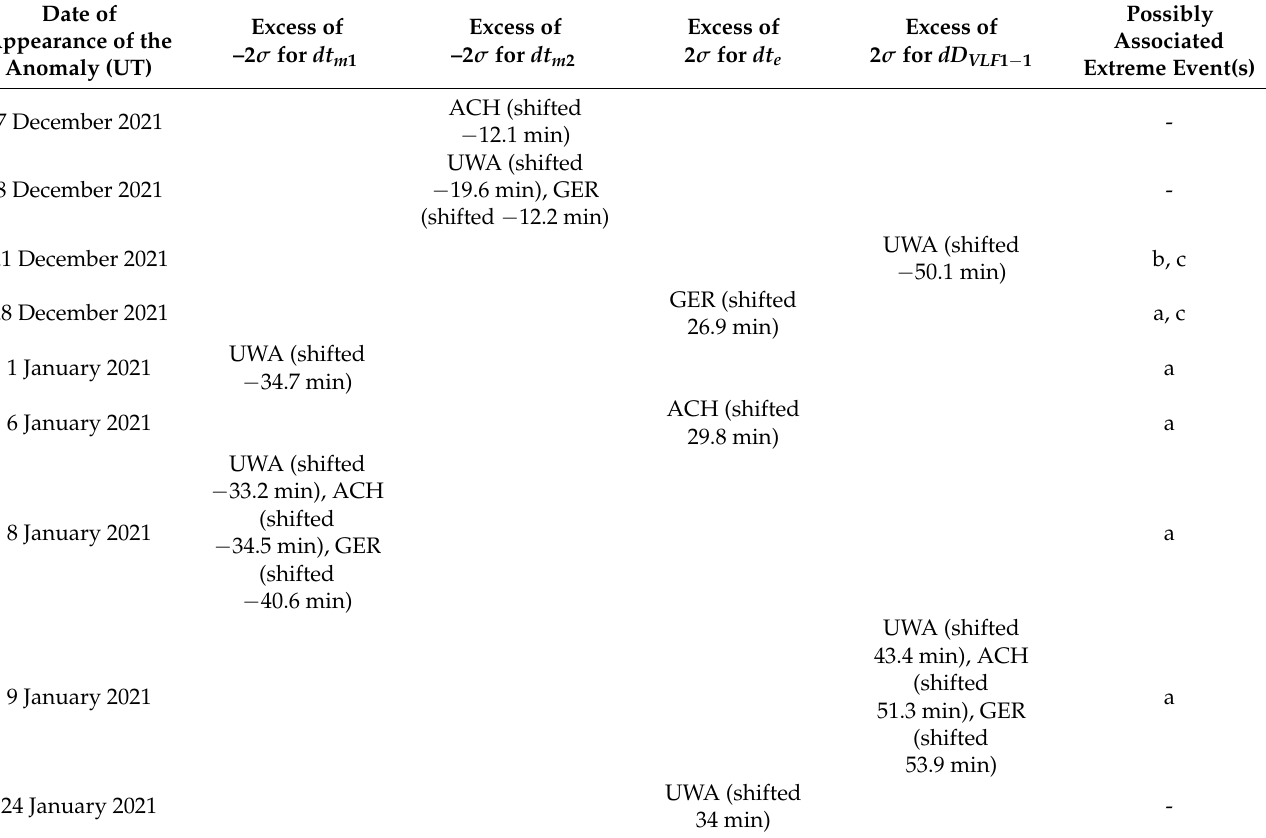
Table 6. Results of TTM analysis for the 2022 Cyprus EQ. UWA, GER, and ACH denote the station where the corresponding anomaly has been